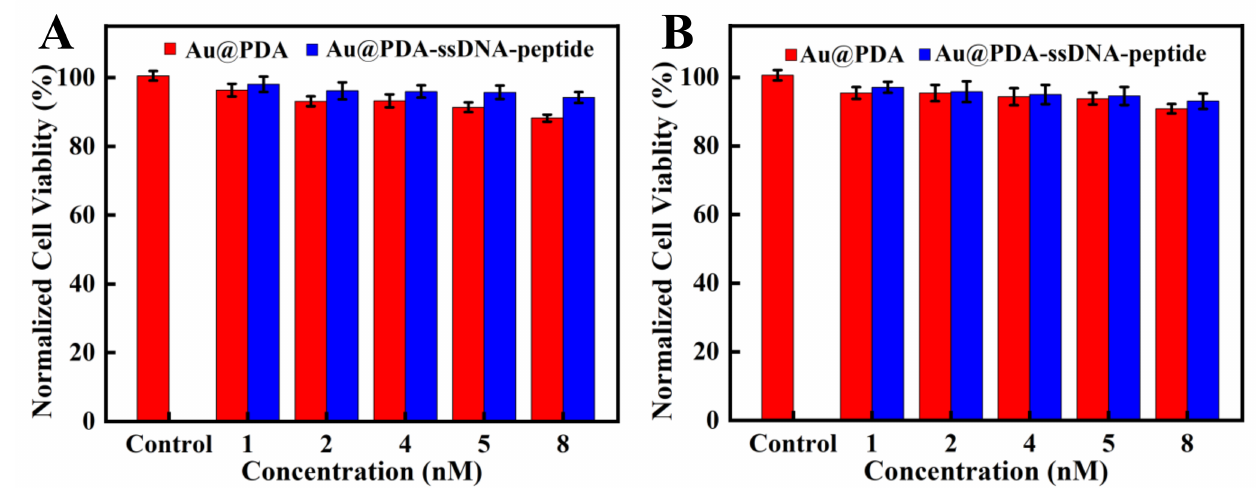
Figure 5. MTT assays of A549 cells ( A ) and Hela cells ( B ). The cells were incubated with various concentrations of the nanoprobe for 24